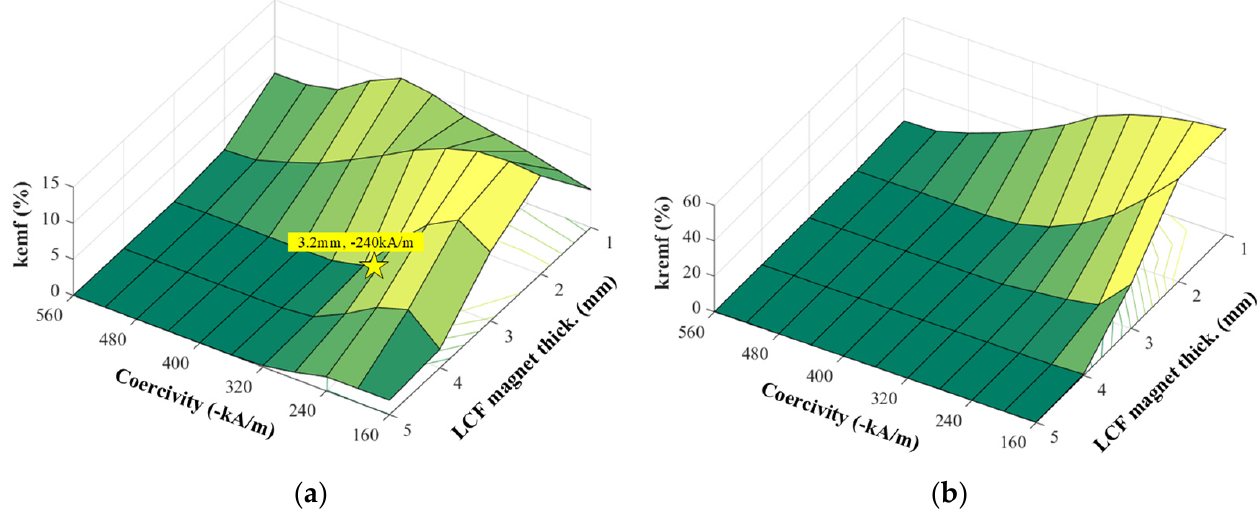
Figure 12. Variation of coefficients with magnet parameters. ( a ) k emf . ( b ) k remf .